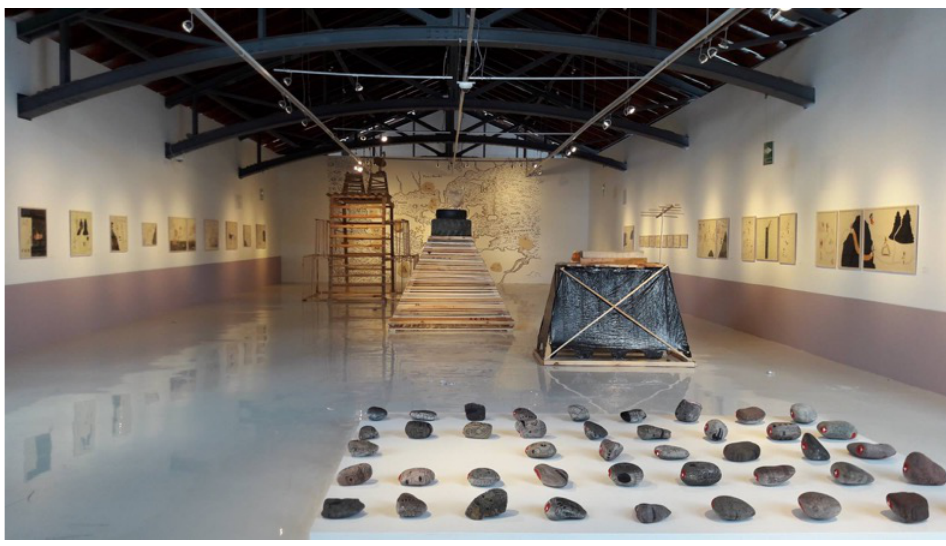
Gabriel Garcilazo’s exhibition Distopías: Gabriel Garcilazo at Museo Universitario del Chopo, March–April 2017. Image courtesy of the artist. (photo: Gabriel Garcilazo)